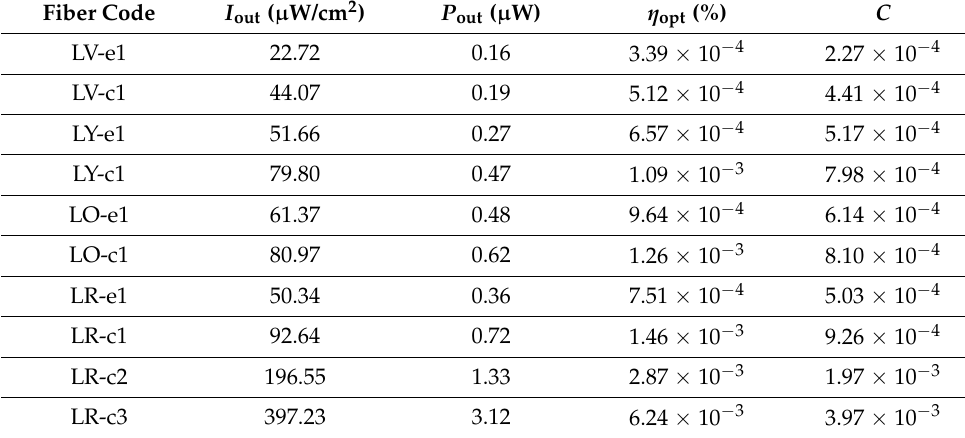
Figure 5. Output intensity as a function of the illuminated length (z e ) on the fiber for the three samples doped with lumogen red (LR) under sun-simulator lamp exposure; the solid-lines are guides to the eye. Table 2. Output intensities and powers, optical efficiencies (%) and concentration factors C of the fibers doped with lumogen dyes calculated with an illuminated fiber length z e = 5